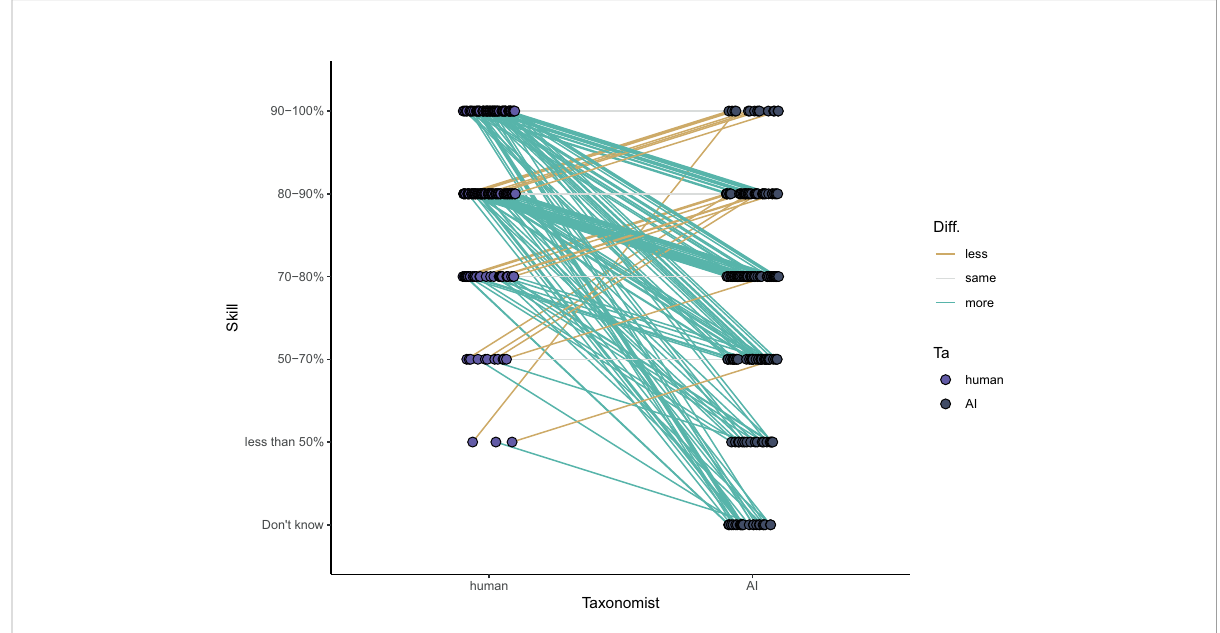
FIGURE 7 Opinions on the level that humans and AI can correctly identify zooplankton. Lines indicate whether a participant thinks humans are more accurate than AI (green), equally accurate (grey) or less accurate (yellow) than